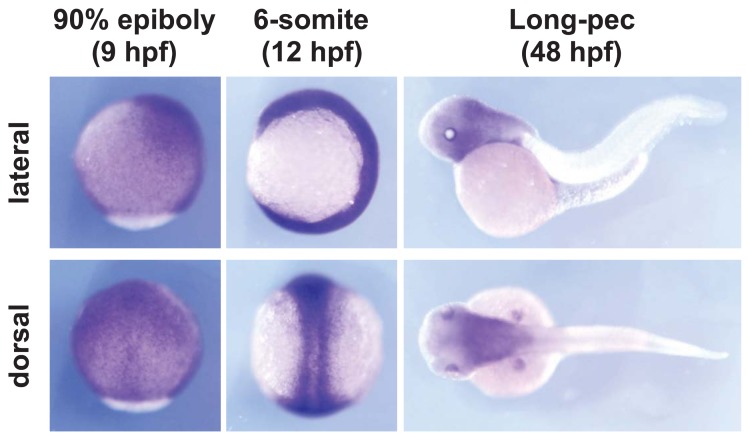
celf1 expression in zebrafish embryos. Lateral (upper panels) and dorsal views (lower panels). We could observe dotted signals at 9 hpf (left panels), reminiscent for the distribution of endoderm cells in this stage (see also Figure 1A). Although endoderm cells distributed in a salt and pepper pattern at 12 hpf as shown in Figure 1C, the salt and pepper distribution of celf1 could not be seen in embryos at 12 hpf. At 48 hpf, celf1 was expressed in pectoral fins, heads and eyes, but not in endoderm-derived organs. Because mouse Celf1 and chick Celf1 are expressed in livers [26–30], we think that the expression patterns of celf1 are specific for zebrafish.